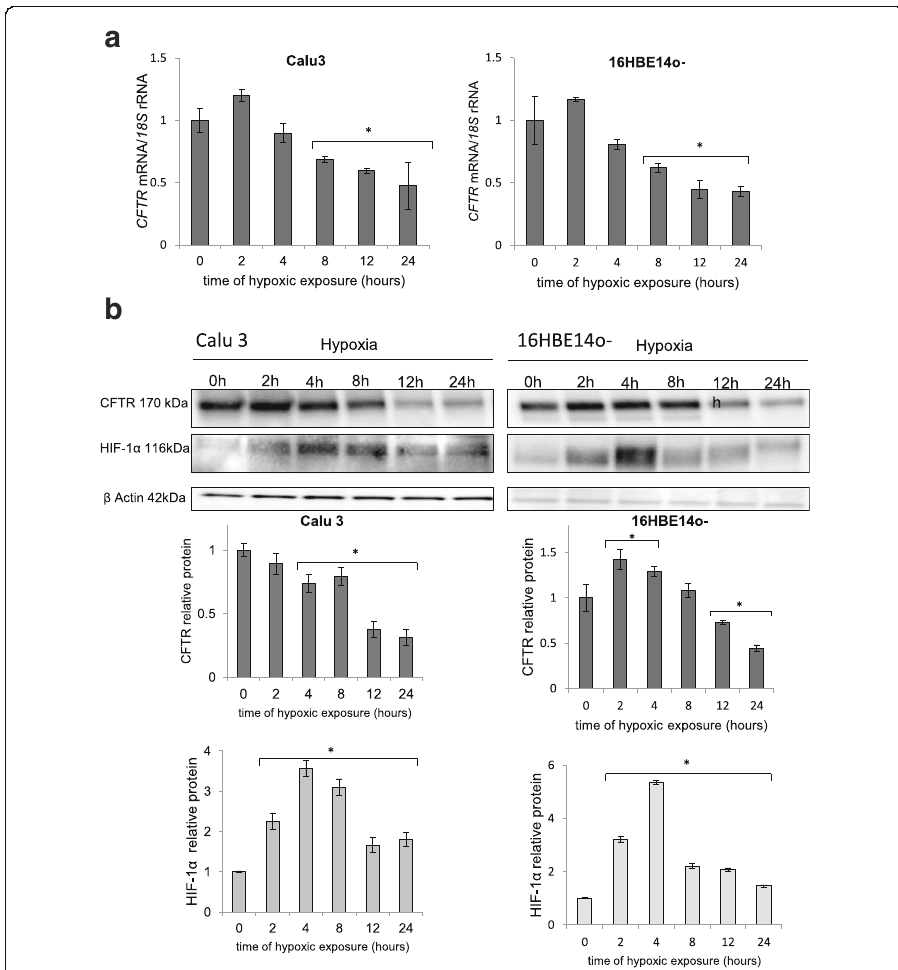
Fig. 1 Regulation of CFTR during hypoxia in human lung epithelial cells, Calu3 cells (left panels) and 16HBE14o- cells (right panels). a CFTR mRNA is reduced during hypoxia. CFTR mRNA levels were monitored in qRT-PCR experiments. The results from 3 independent experiments ( n = 12) are plotted normalized to 18S rRNA levels and expressed as a fold-change over the normoxic control. b Hypoxia sequentially increases HIF-1 α protein levels and reduces CFTR protein levels. Protein expression levels of were monitored with SDS-PAGE and Western Blot and normalized to β -actin levels. Two individual samples (4 μ g of total protein per lane) were tested for each time point and the experiments were repeated twice. Error bars represent standard deviations. Significant changes ( P < 0.05) are marked with an